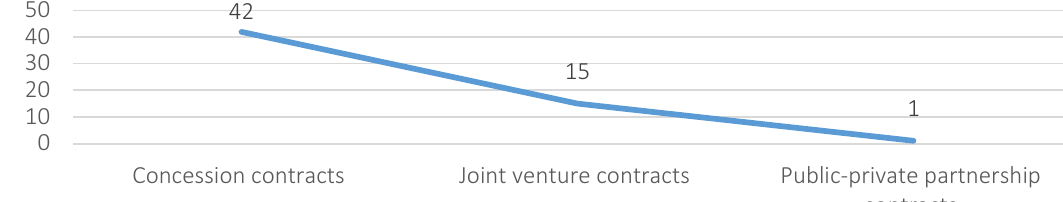
Figure 5. Contracts being implemented